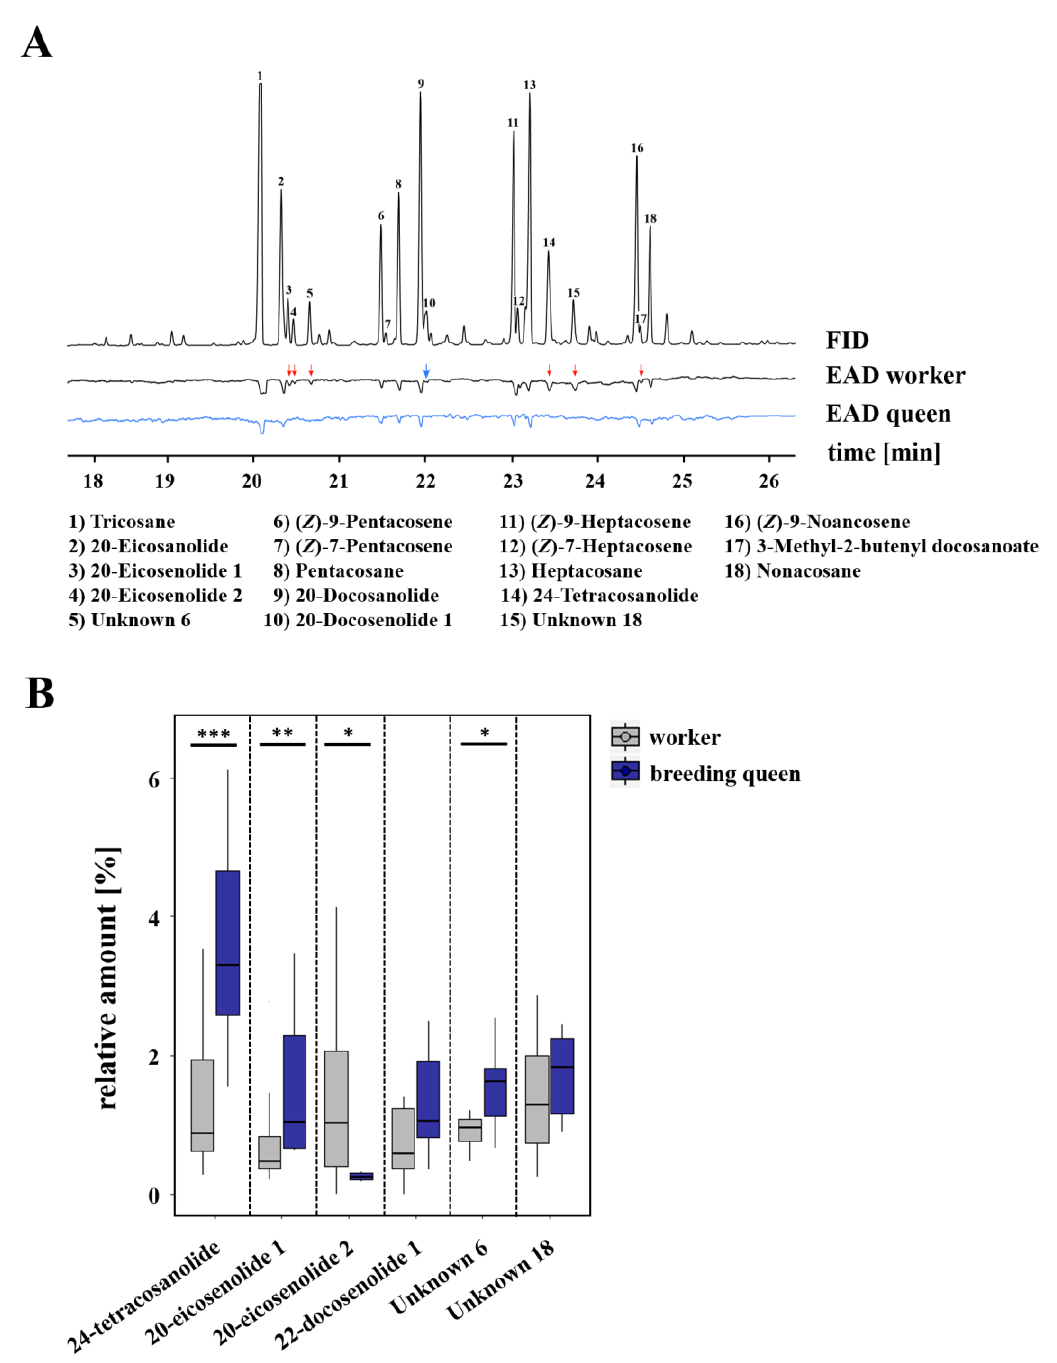
Figure 4. ( A ) Examples of coupled gas chromatographic and electroantennographic detection (GC-EAD) in cuticle surface extracts of L. malachurum queens by using antennae of L. malachurum workers (black) and queens (blue). Numbers indicate compounds that were electrophysiologically active (EAD-active) in at least four runs of workers or queens. Red arrows indicate those compounds that were perceived only by either workers or queens. For a better graphical presentation, antialiasing was performed on the baseline by using Adobe Illustrator CC v.18.0.0. ( B ) Comparison of relative amounts of those compounds which were only perceived by workers or queens. Bars represent the median as well as the 25th and 75th percentiles (asterisks indicate significant differences, Mann–Whitney U tests: 24-tetracosanolide p < 0.001, 20-eicosenolide 1 p = 0.007, 20-eicosenolide 2 p = 0.011, Unknown 6 p =